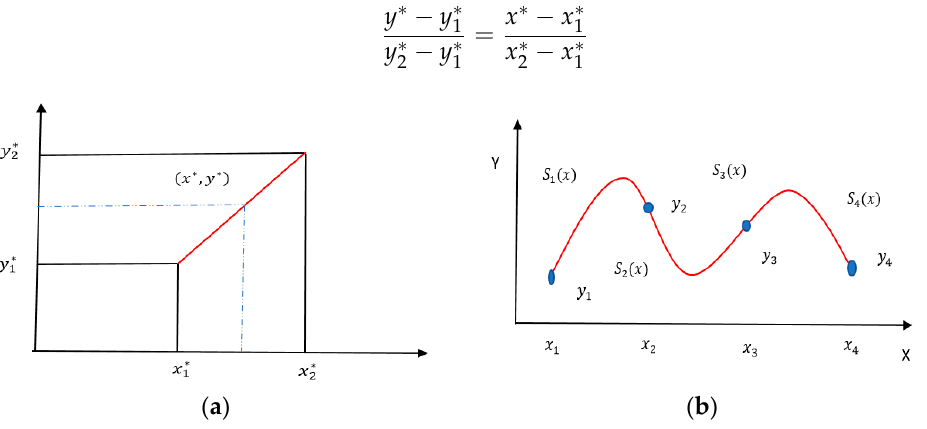
Figure 1. The concept of linear interpolation ( a ) and cubic spline interpolation ( b ). y ∗ = linear interpolation